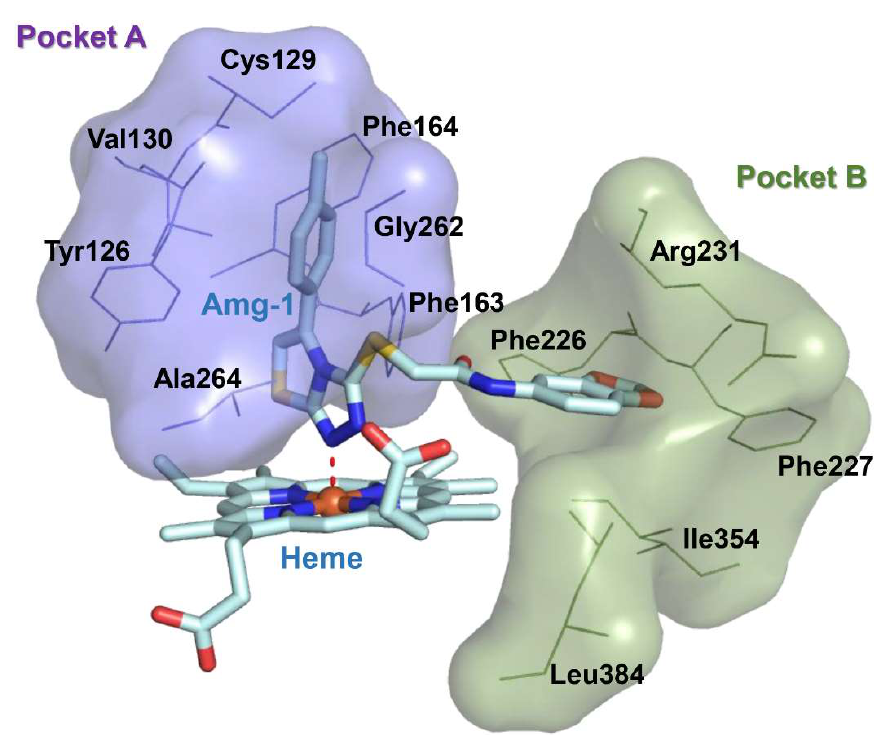
Figure 2. Pocket surface map of the crystal structure of IDO1 complexed with Amg-1 (PDB code: 4PK5). Purple represents amino acids contained in pocket A; green represents amino acids contained in pocket